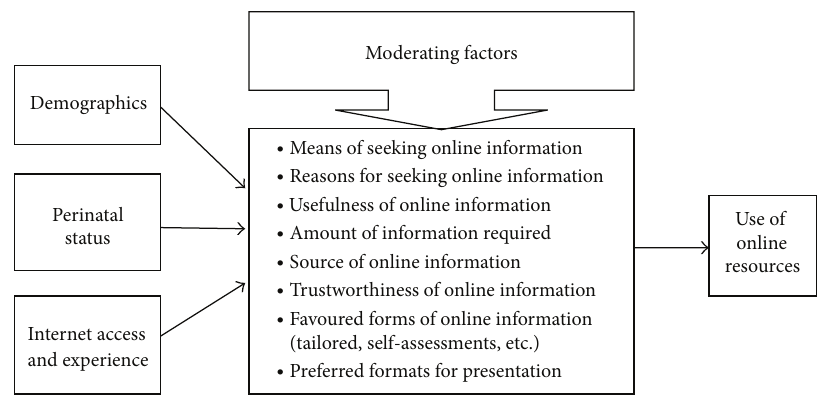
Figure 1: Theoretical framework to review the use of online healthy lifestyle